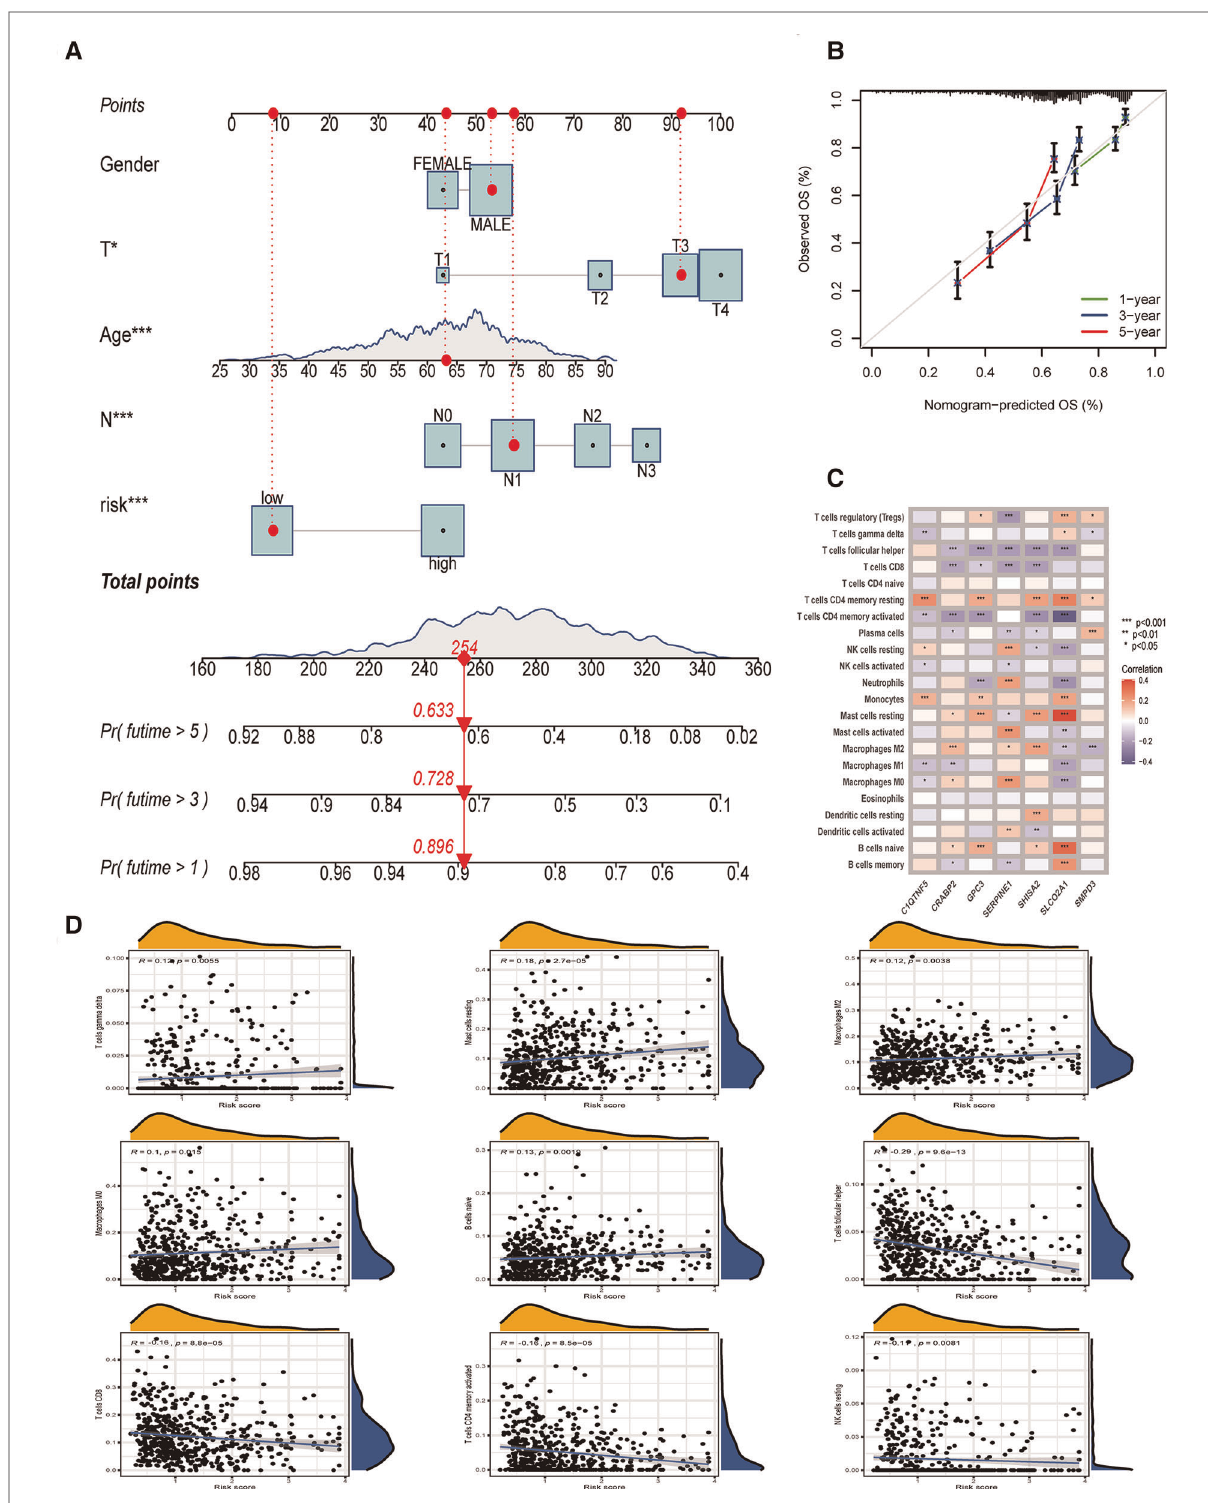
FIGURE 6 The establishment of nomogram, and the relationship between OE_score and tumor immune microenvironment. ( A ) Nomogram based on OE_score and other clinical factors to predict 1-, 3-and 5-year survival rates in patients with gastric cancer. ( B ) The calibration plot of the nomogram. ( C ) The relationship between the genes involved in the construction of OE_score and the expression of immune in fi ltrating cells. ( D ) The correlation between OE_score and immune in fi ltrating